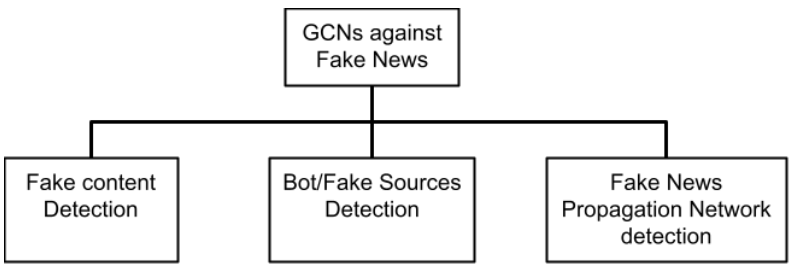
Figure 2. The three main directions in the use of GCNs in fake news detection